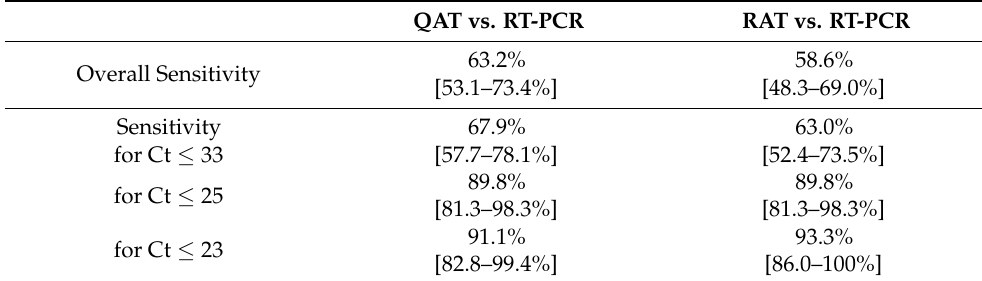
Table 1. Comparison of QAT and RAT with